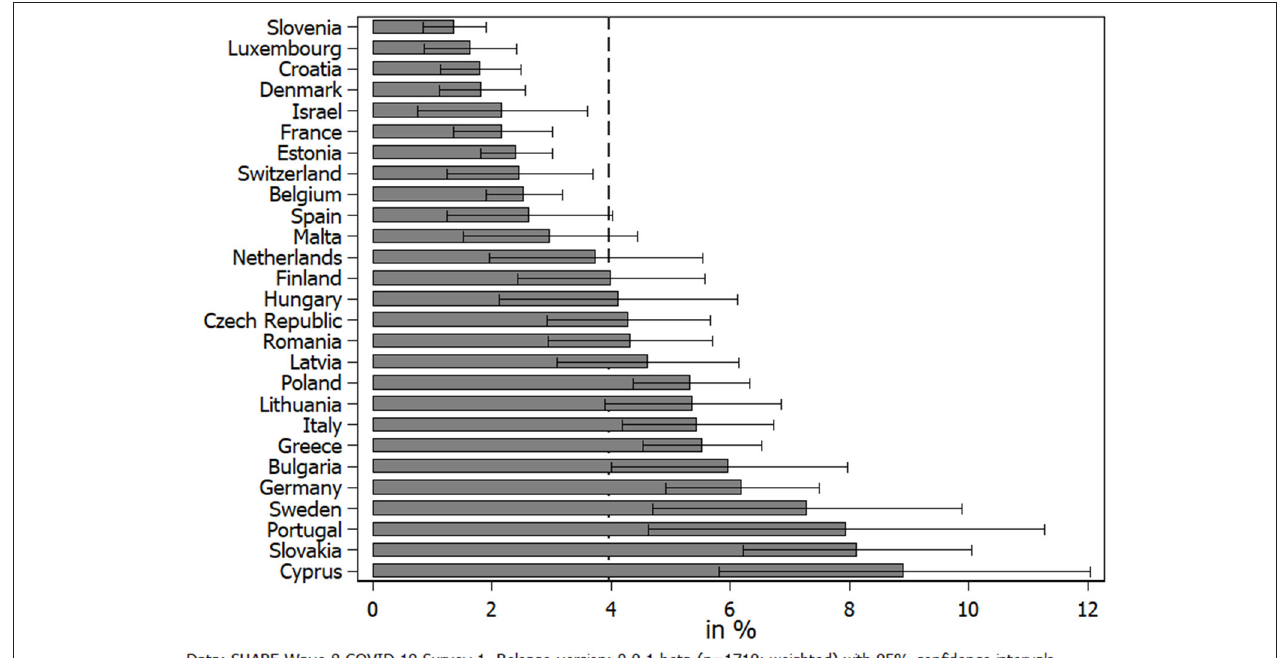
FIGURE 1 | Percent of respondents providing personal care to others outside their own household since the outbreak of the